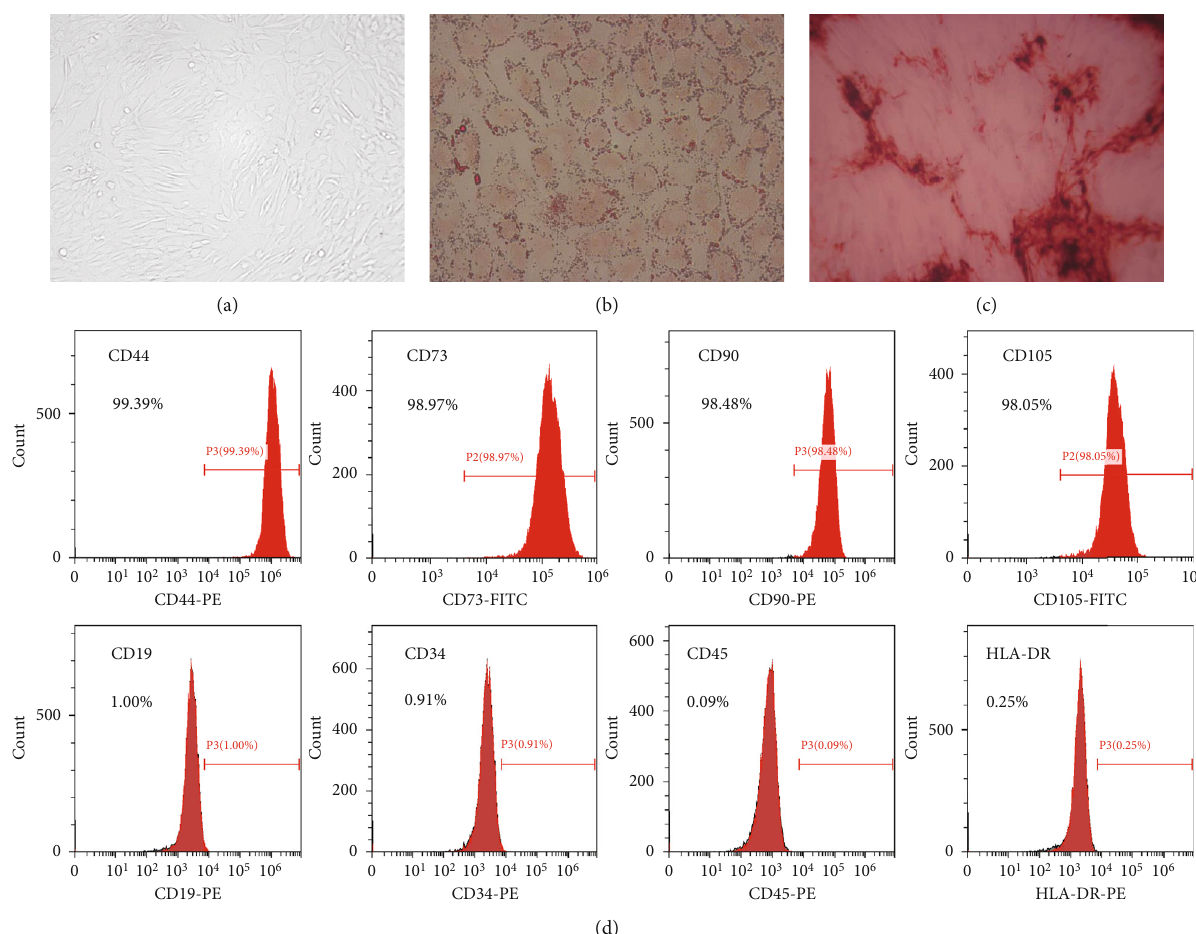
Figure 1: Characterization of UC-MSCs: (a) plastic adherence and fi broblast-like morphology of UC-MSCs (magni fi cation × 200); (b) adipogenic di ff erentiation of UC-MSCs (Oil Red O staining, magni fi cation × 400); (c) osteogenic di ff erentiation of UC-MSCs (Alizarin Red staining, magni fi cation × 100); (d) UC-MSCs express cell surface markers such as CD44, CD73, CD90, and CD105 but do not express CD19, CD34, CD45, and